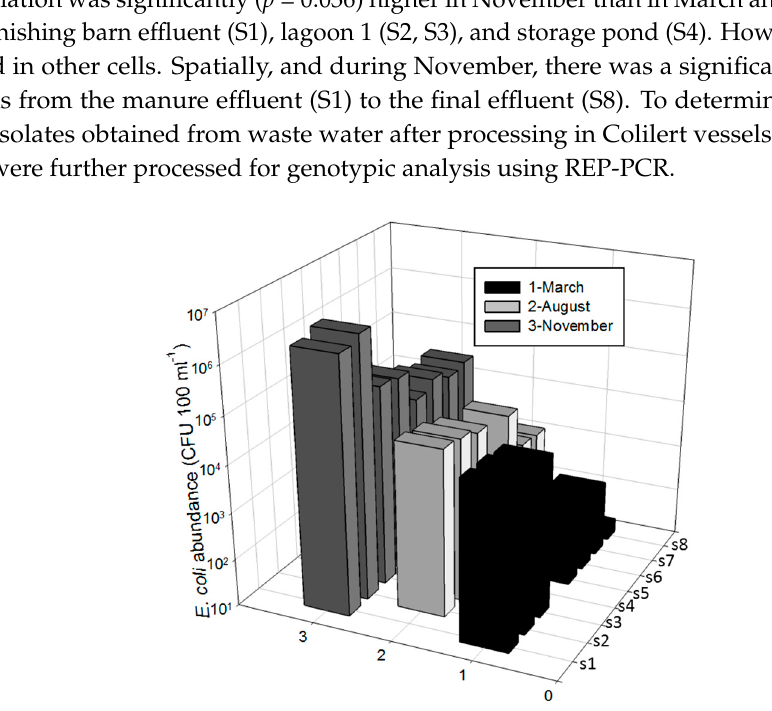
Figure 1. E. coli population in March, August, and November in wetlands. Symbols on the X -axis are effluent from swine house (S1), two-stage anaerobic lagoon system consisting of a primary lagoon 1 (S2) with overflow into a secondary lagoon 2 (S3) that flows to the storage tank (S4), continuous wetland cell influent (S5), continuous wetland cell effluent (S6), storage pond (S7), final effluent samples (S8) where it was recycled for flushing of the swine production facility and for land application). All samples were collected in duplicate.